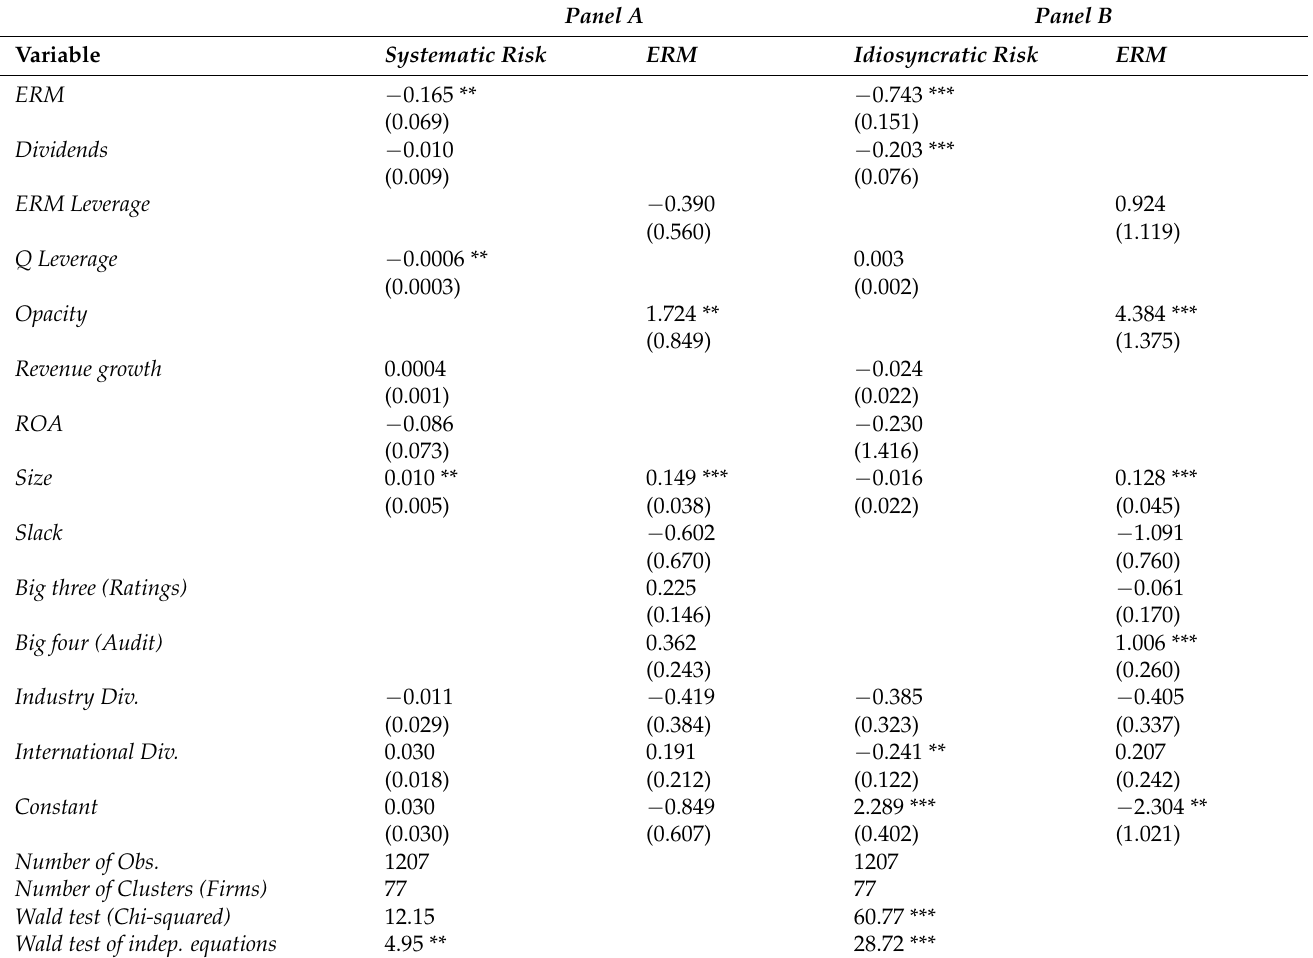
Table 7. Full maximum likelihood treatment effects model—Systematic and idiosyncratic